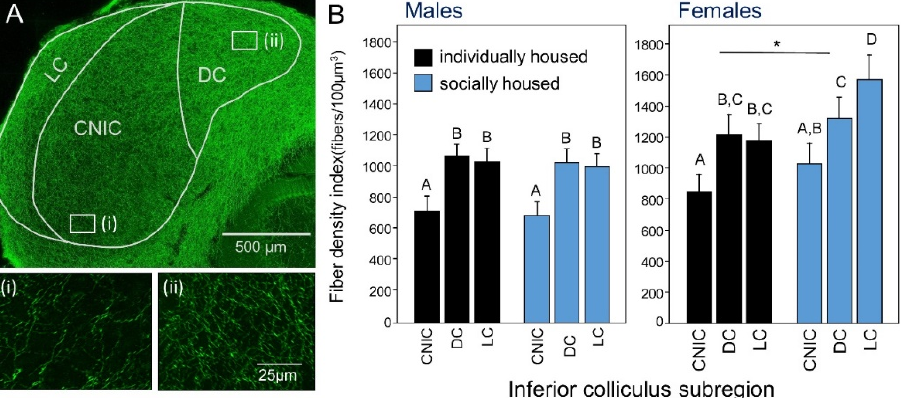
Figure 1. ( A ) Axons from serotonergic neurons form a dense network in the inferior colliculus (IC). Photomicrographs with higher magnification labeled (i) and (ii) at the bottom of panel A correspond to the white boxes in the top panel. The subdivisions of the IC are also indicated on this photomicrograph: CNIC = central nucleus of the IC; DC = dorsal cortex of the IC; LC = lateral cortex of the IC. ( B ) Fiber densities in mice housed individually versus in social groups for one month after weaning, across distinct subregions of the IC. Fiber densities are highest in females housed socially (* p < 0.05). Figures adapted from reference [88] with permission from the authors.